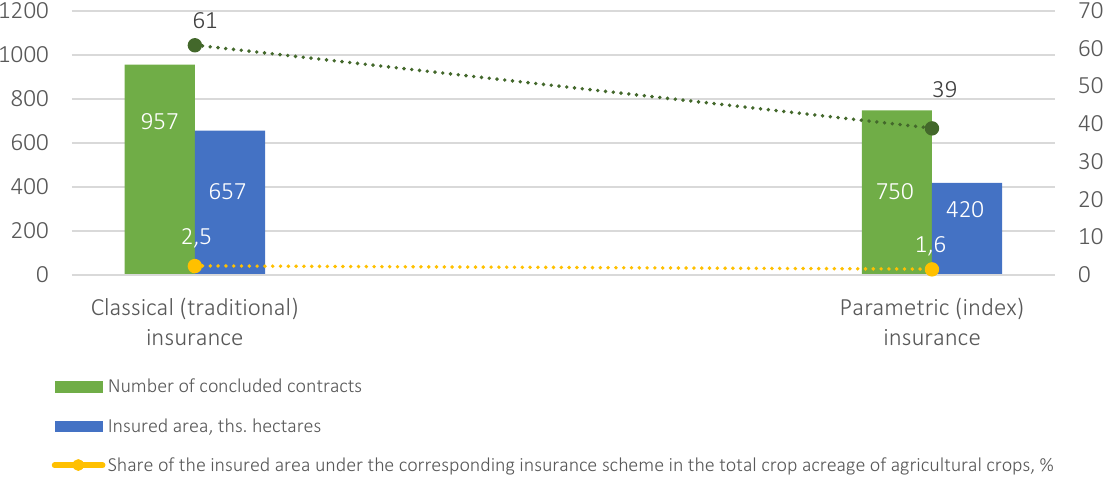
Figure 10. Ukrainian agricultural insurance market in terms of classical and parametric insurance schemes